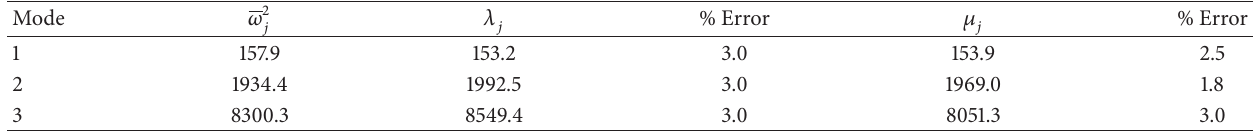
Table 17: Optimal frequencies and MRQA (Case 3).